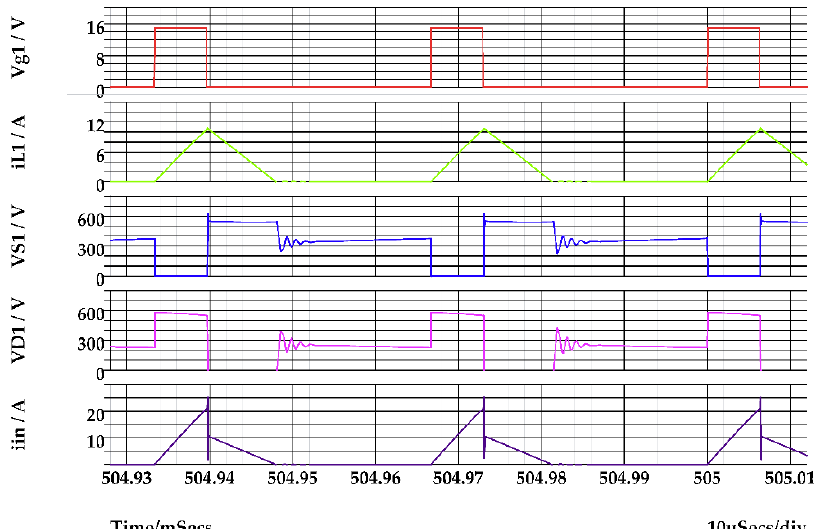
Figure 10. The key time-domain waveforms at v in = 220 V rms .